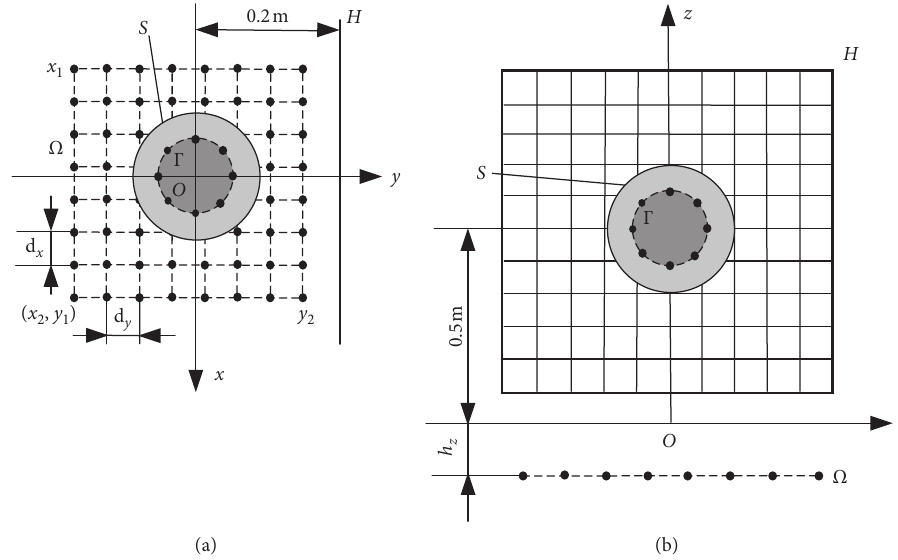
Figure 1: Positions of the spherical source S , the hologram surface H , and the fictitious surface Γ and Ω . (a) Top view. (b) Side